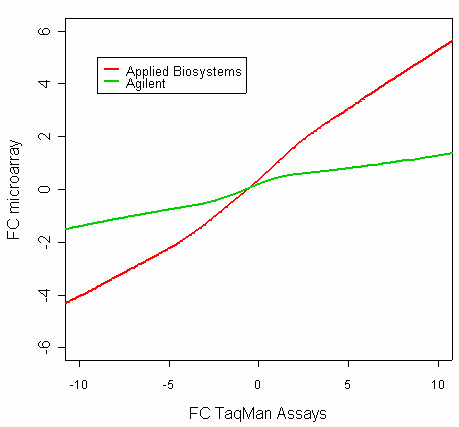
Fold change repression in microarray platforms. Fold change of pair-wise tissues (brain vs. liver, brain vs. lung and liver vs. lung) determined by each microarray platform (y-axis) were plotted aganinst those determined by TaqMan Assays (x-axis). Genes were filtered based on real-time PCR detection thresholds (detectable in at least 3 out of 4 technical replicates in at least one of the three tissues). The lines represent lowess smoothing fitting curves to 3,105 data points (sum of all three pair-wise tissues) in each platform.